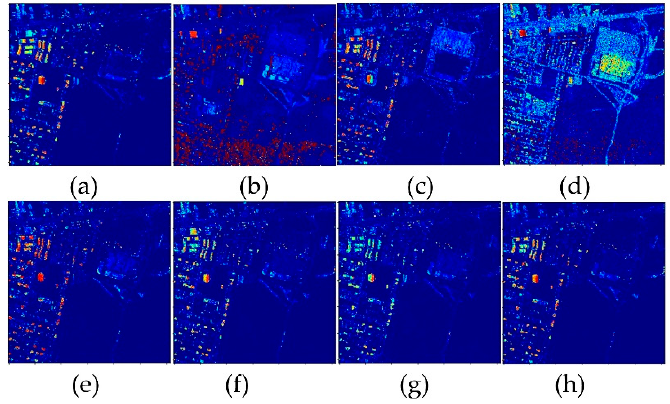
Figure 6. Estimated maps of the endmember “Metal” when 5% samples of the noisy data are utilized for training. ( a ) Ground truth; ( b ) CNN; ( c ) STFHU; ( d ) STCNN; ( e ) ResNet; ( f ) AResN; ( g ) RNST; and ( h ) ARNST.